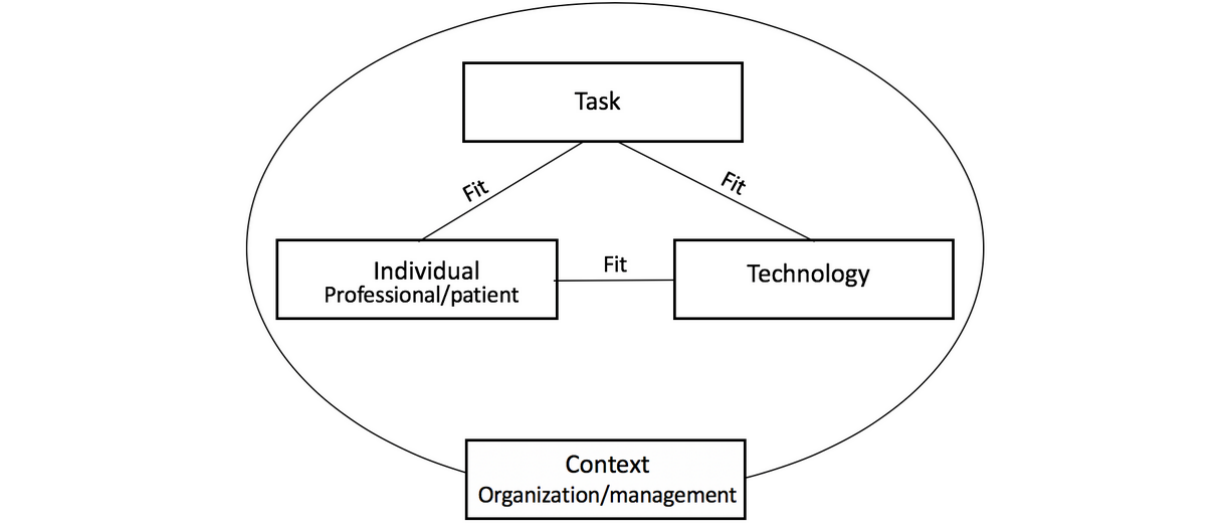
Figure 1. Extended FITT (Fit between Individuals, Task, and Technology)